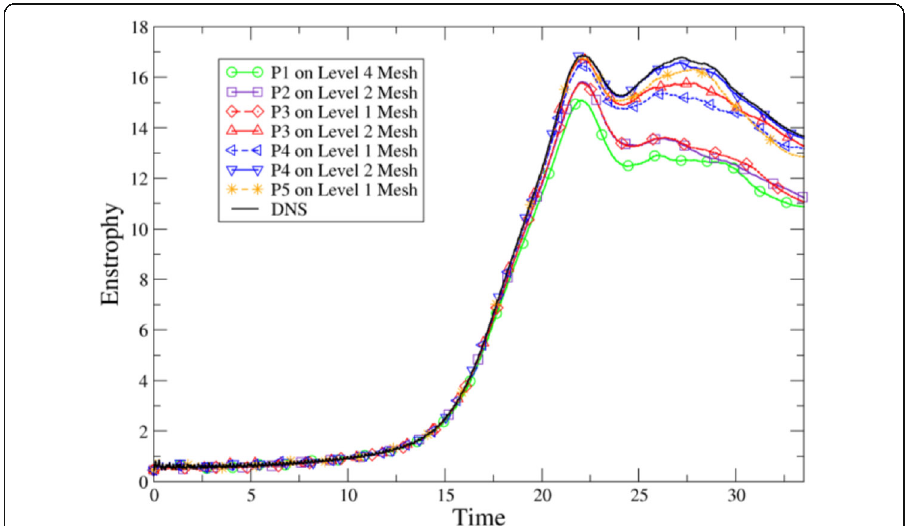
Fig. 12 Histories of enstrophy in an hp-refinement